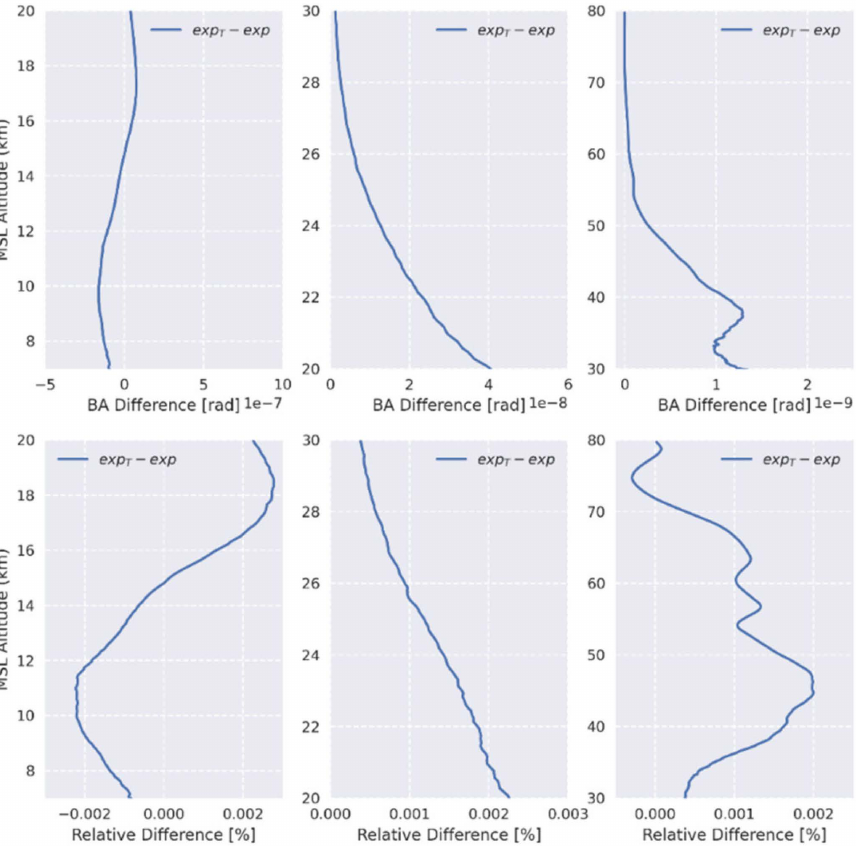
Figure 5. Difference (first row) and RD (second row) between the exp_T and exp algorithms. Table 1. Relative difference, (E − T)/T × 100%, between the FY3D BA (T) and the forward-modeled BA (E), in which E can be the exp and direct algorithm, and each algorithm has two interpolation methods: log linear (denoted by lin) and cubic spline (no